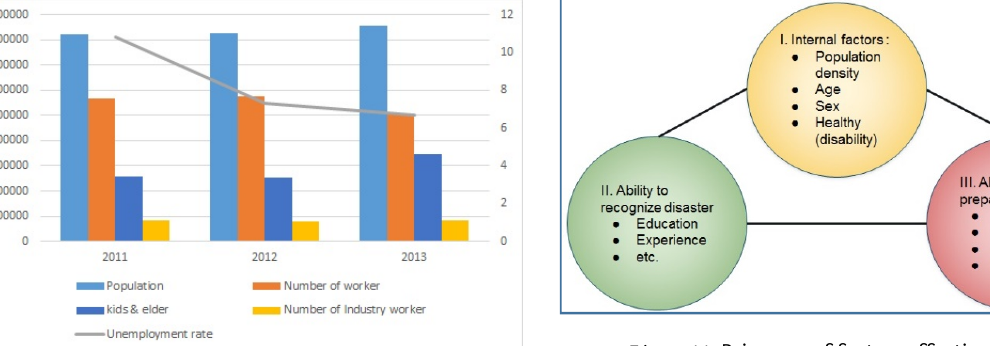
Figure 10. Graph of workers, population, and unemployment rate in Cilacap